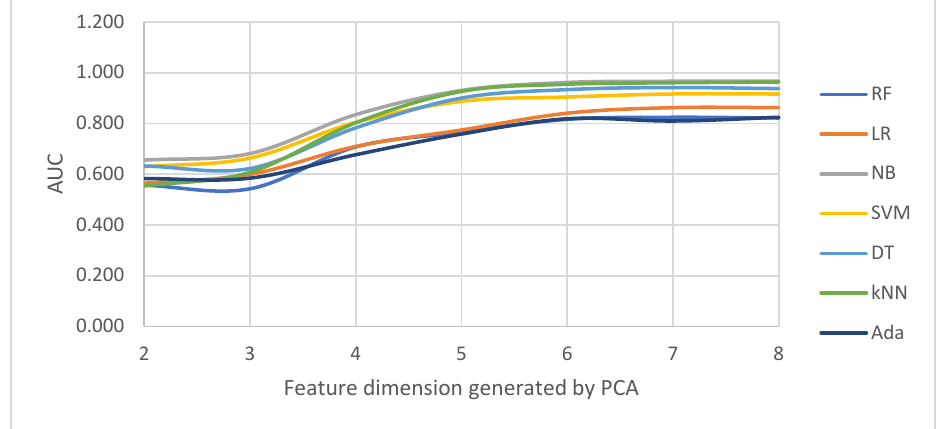
Fig. 10. AUC results for the comparison between different machine learning models using PCA